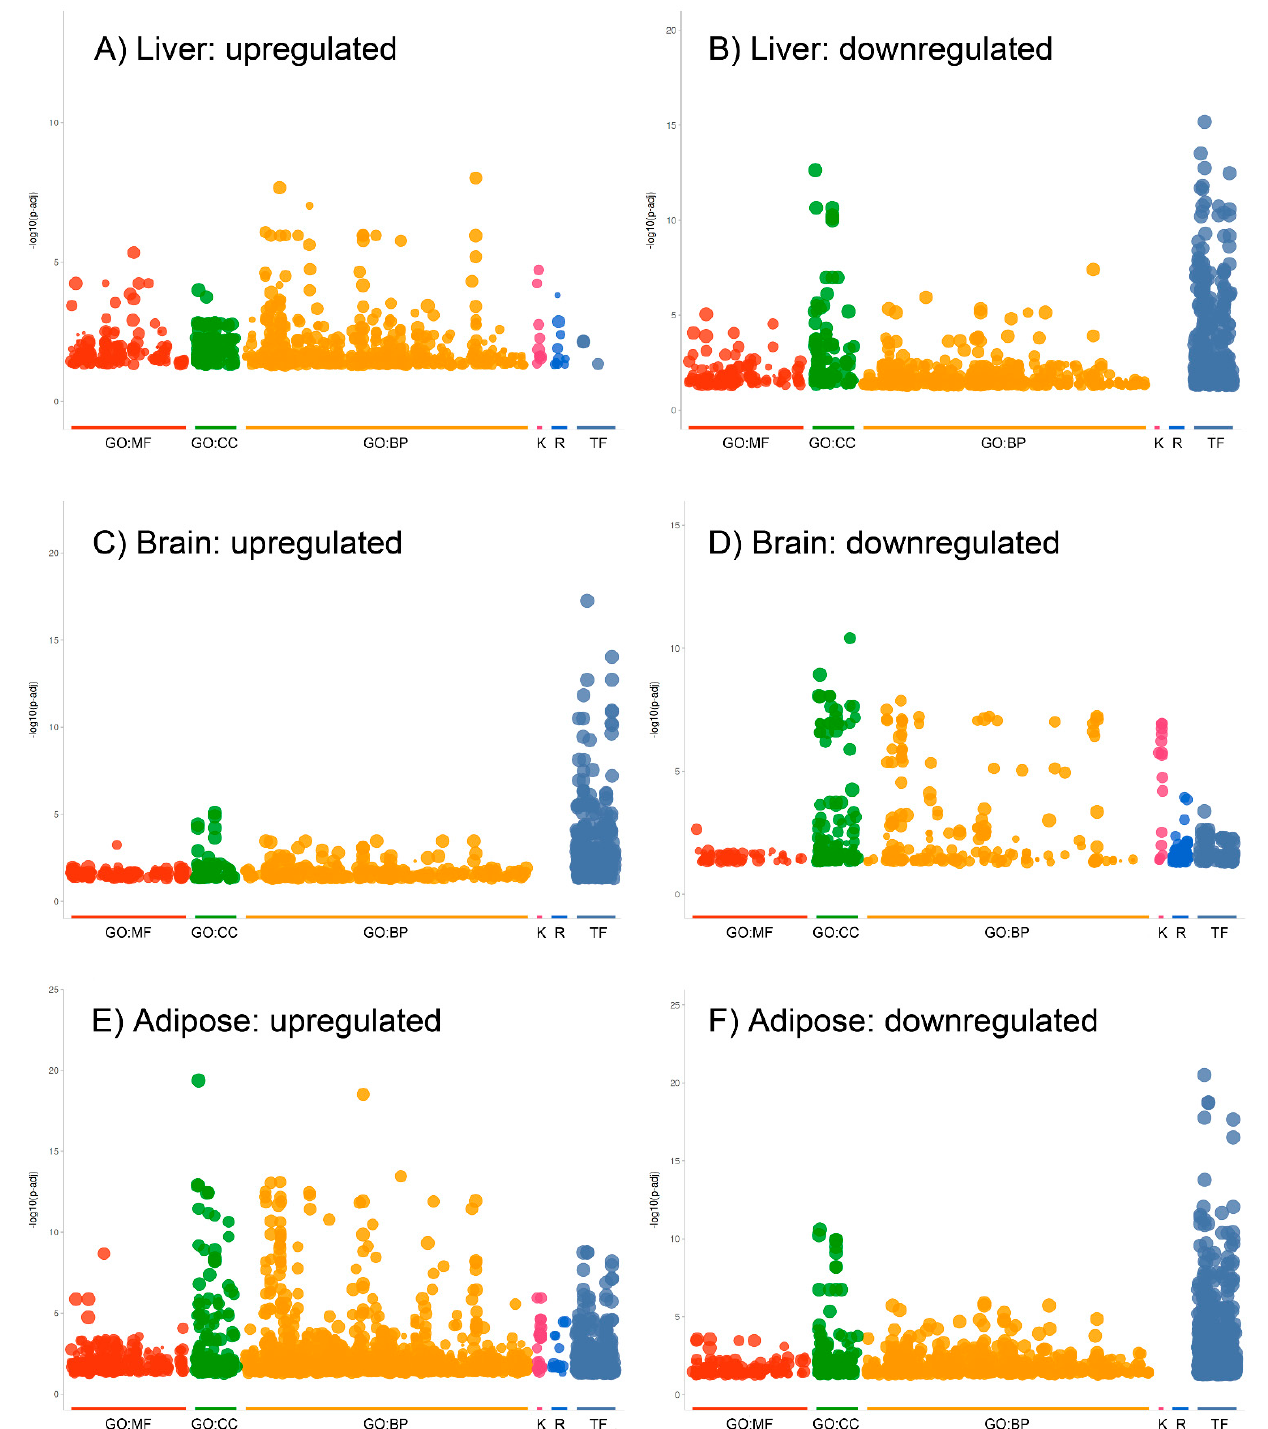
Figure 6. g:Profiler2 Manhattan plots of the organ-specific effects of Acss2 deletion. ( A ) Analysis of upregulated DEG in liver revealed enrichment of 820 biological processes (GO:BP), but indicated over-representation of only 13 transcription factor motifs (TF). ( B ) Downregulated DEGs in liver showed over-representation of 239 GO:BP and 590 TFs. ( C ) Upregulated DEGs in brain showed 711 enriched biological processes and 466 enriched TFs. ( D ) Downregulated genes in brain indicated enrichment of 676 biological processes and enrichment of 98 TF. ( E ) Upregulated genes in adipose tissue indicated over-representation of 1330 GO:BP and 397 TF. ( F ) Downregulated genes in adipose tissue revealed enrichment of 1497 GO:BP and 578 TF. Overall, there were significant effects on transcription factor expression, and in the cases of the brain and liver, the effects were directional (TF mostly upregulated in the brain, but mostly downregulated in the liver). The X axes show the